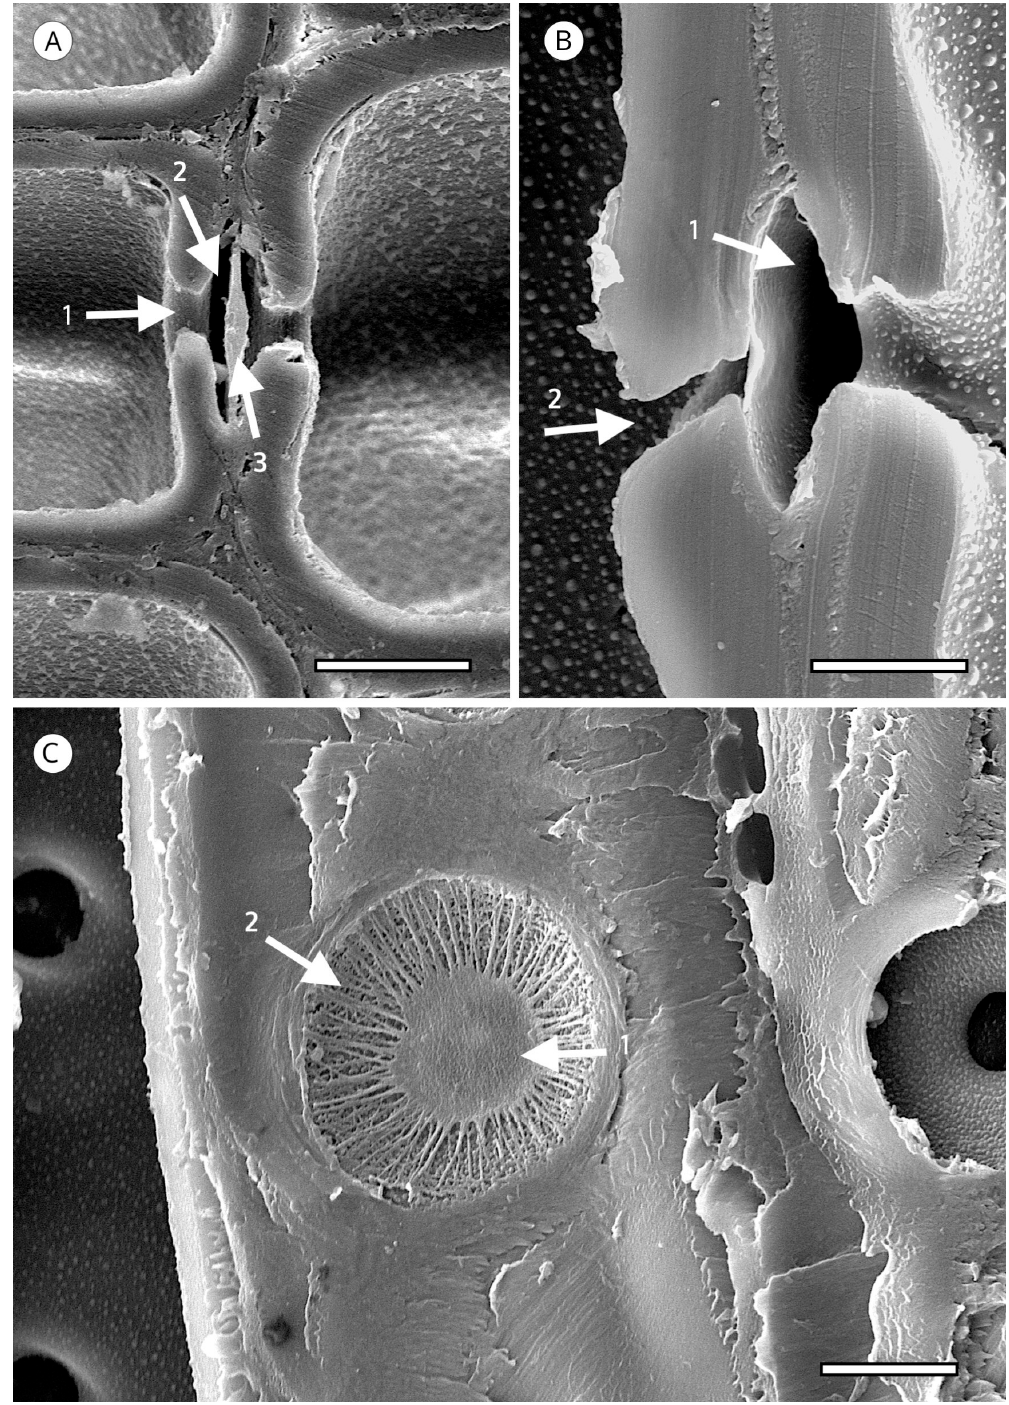
Figure 12. Tracheid pits. ( A ) Juniperus barbadensis L. (SEM), 1. Aperture; 2. Dome or chamber; 3. Torus; ( B ) Callitropsis nootkatensis (D.Don) Oerst. (SEM), 1. Dome or chamber; 2. Aperture; ( C ) Hesperocyparis sargentii (Jeps.) Bartel (Syn.— Cupressus sargentii Jeps.) (SEM). 1. Torus; 2. Margo . Scale bars. ( A ) = 10 μ m; ( B , C ) = 5 μ m.